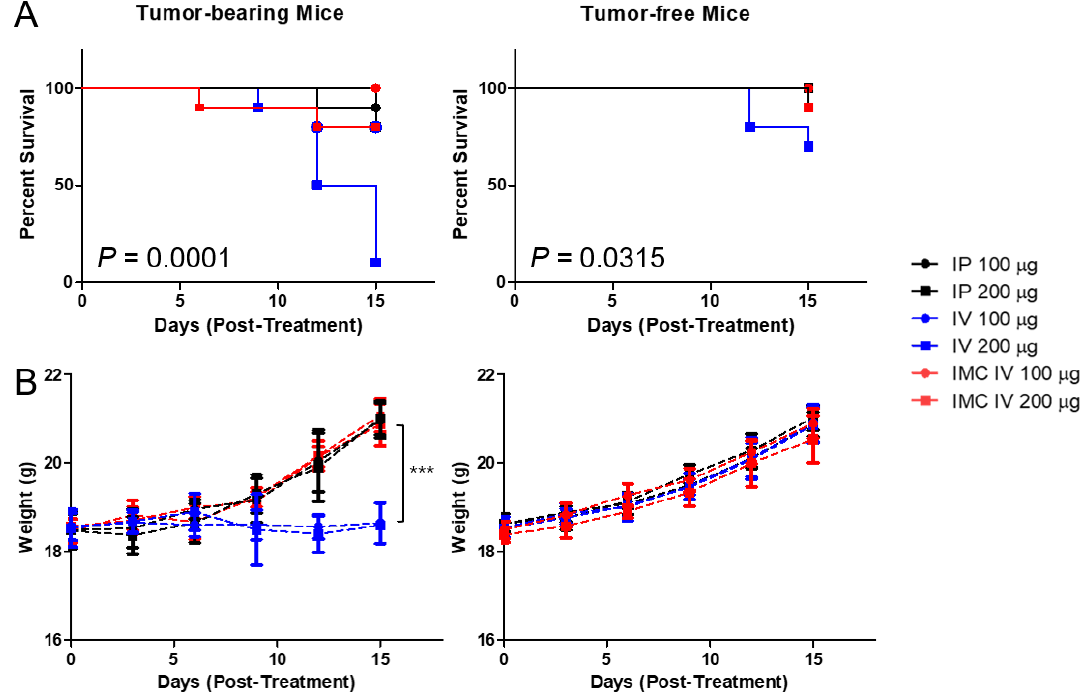
Figure 4. The survival analysis of anti-PD-L1 antibody administered CT26-wt tumor-bearing mice and the evaluation of the effects of the dose and different routes of administration. ( A ) The intravenous injection of PD-L1 antibodies at higher doses (200 μg) in tumor-bearing and tumor-free mice showed increased adverse effects, as 90% and 30% of the mice died within two weeks after injection, respectively. ( B ) The tumor-bearing mice that were injected with the PD-L1 antibodies intravenously at both high and low doses showed reduced weight gain, which may suggest potential adverse effects induced by these antibodies. All the other mice in both the tumor-bearing and tumor-free groups showed a steady increase in the average body weight over the two weeks. IP—intraperitoneal injection; IV—intravenous injection; Values are mean ± SD ( n = 10 per group). *** p ≤ 0.001.